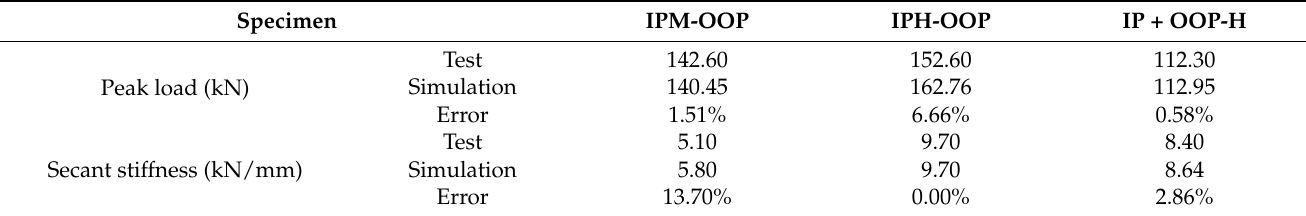
Figure 7. The load-displacement responses of numerical and test results. ( a ) The result of IPM-OOP. ( b ) The result of IPH-OOP. ( c ) The result of IP + OOP-H. Table 8. Comparison between numerical and test stiffness and load-carrying capacity.